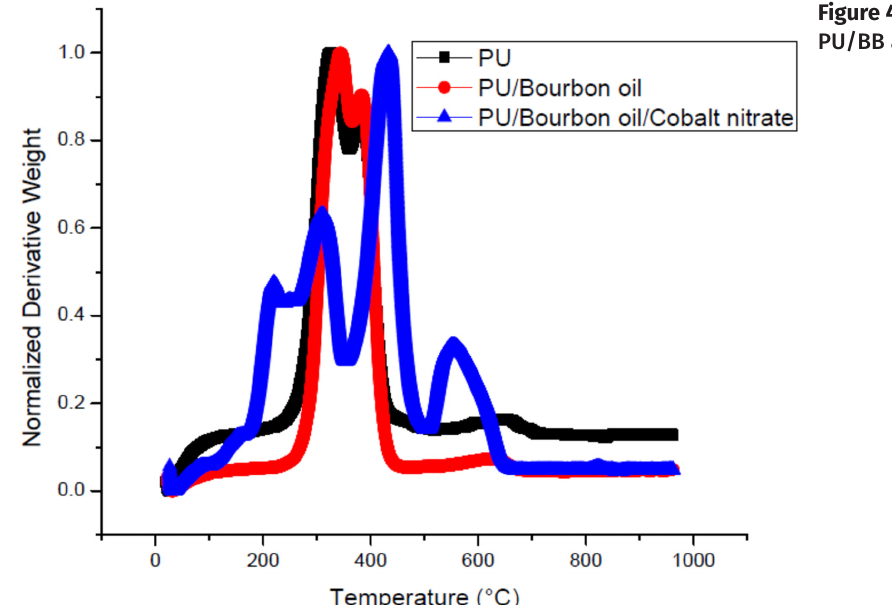
Figure 4. DTG curve of PU, PU/BB and PU/BB/CONO